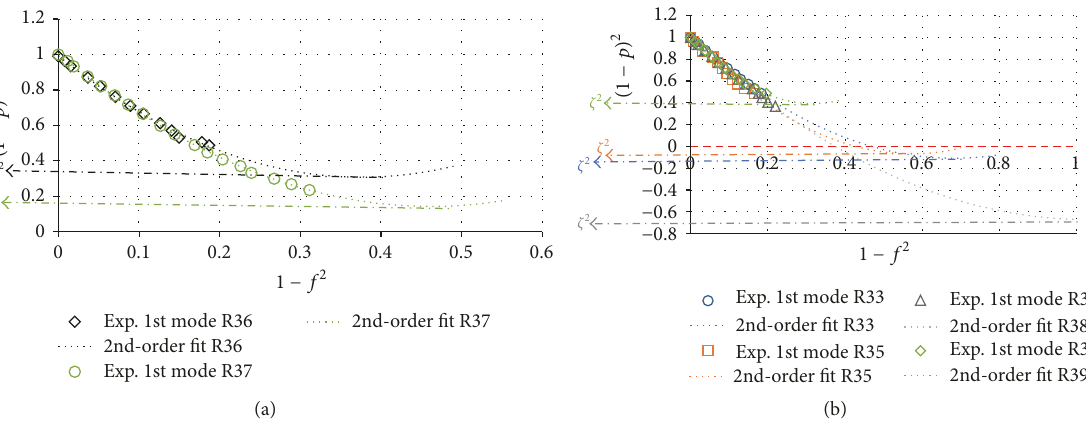
Figure 15: Plot of (1 − 𝑝) 2 as a function of 1 − 𝑓 2 and the second-order fit for cylinders with cutouts that failed without (a) and with local buckling preceding global instability